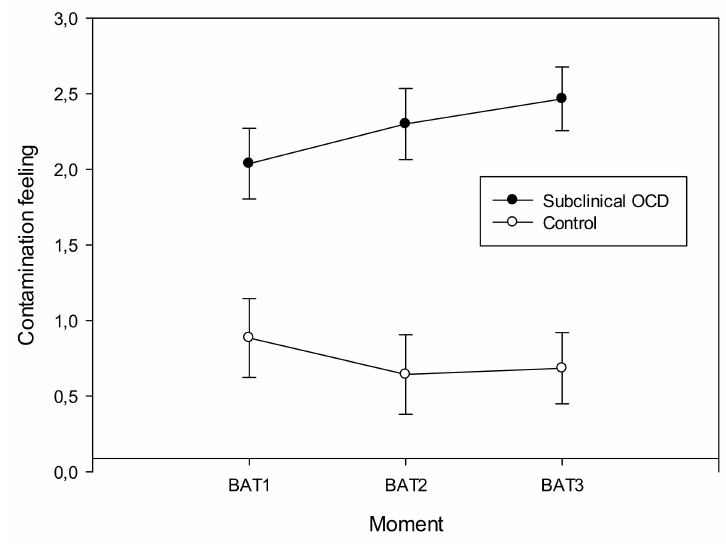
Figure 2. Contamination mean scores and standard deviation during the behavioral avoidance task (BAT) in both